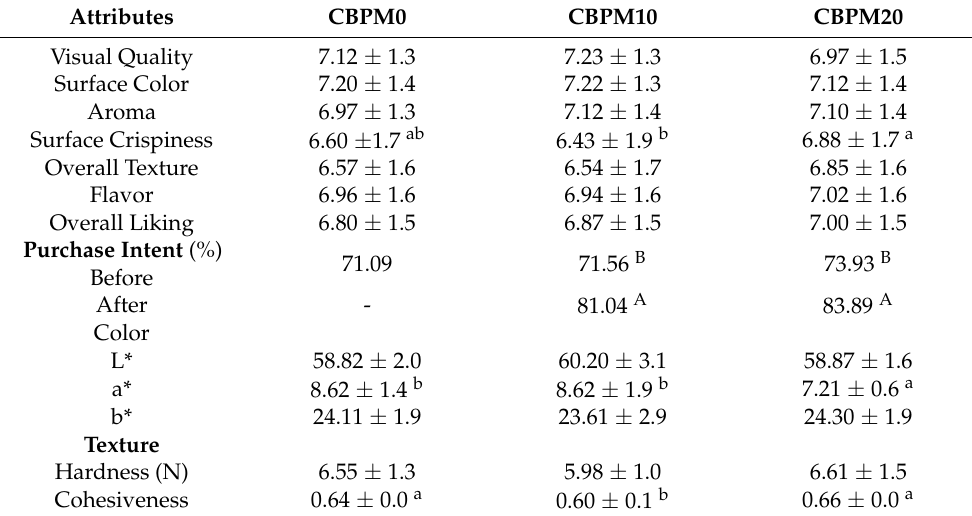
Table 2. Liking 1 , purchase intent 2 , and instrumental color and texture 3 of fried catfish strips dredged with CBP breading mixes